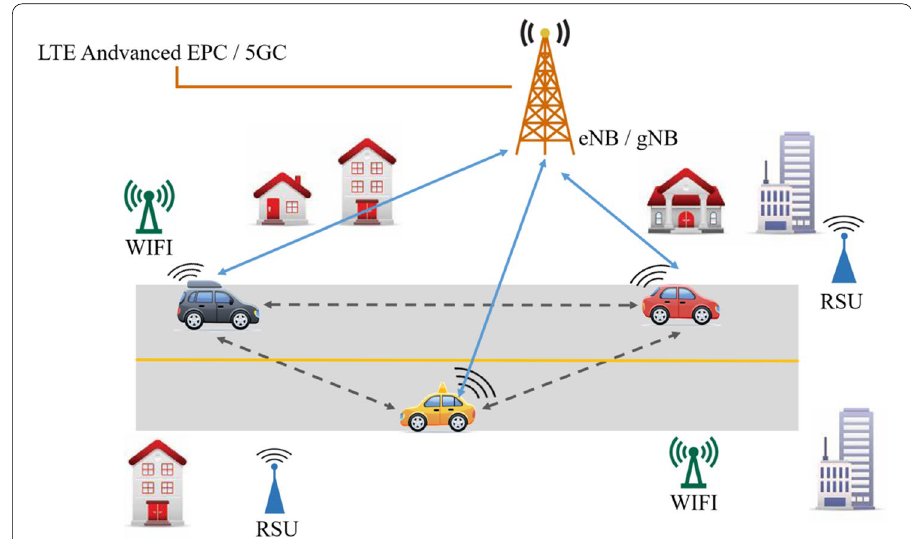
Fig. 18 Internet of vehicles schematic diagram. The transceivers on the vehicles could be the extended RAN nodes for the eNB/gNB